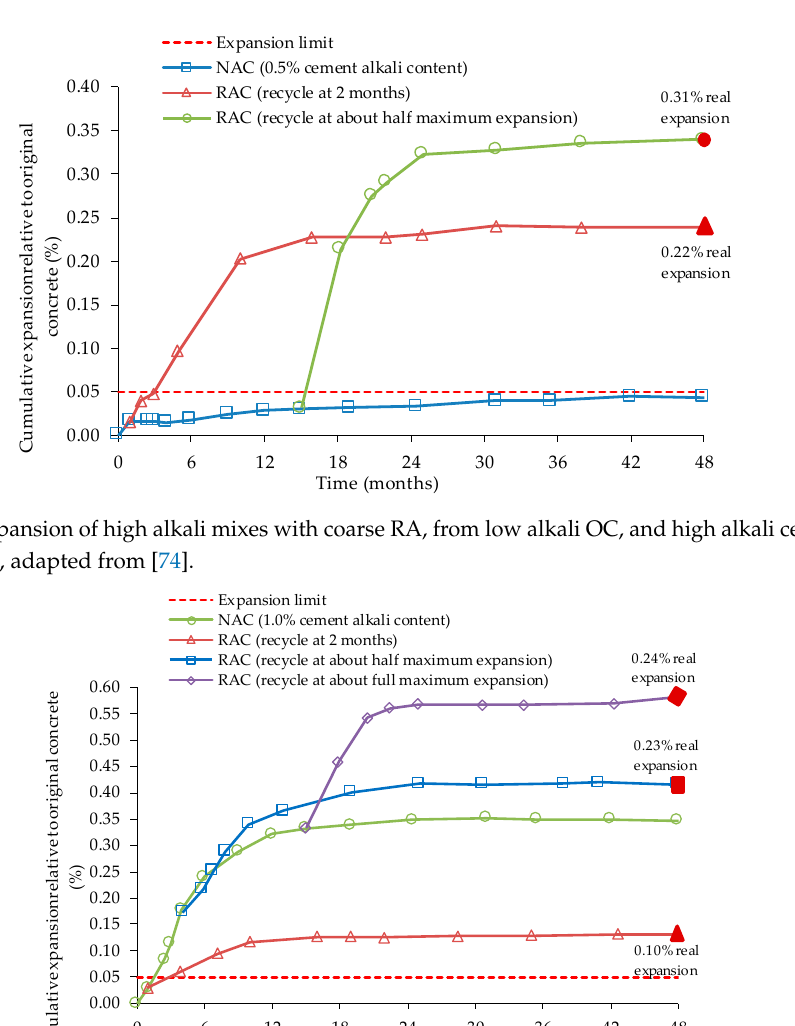
Figure 3. Expansion of NA with cements of different alkalis content in ASTM C227, adapted from [74].